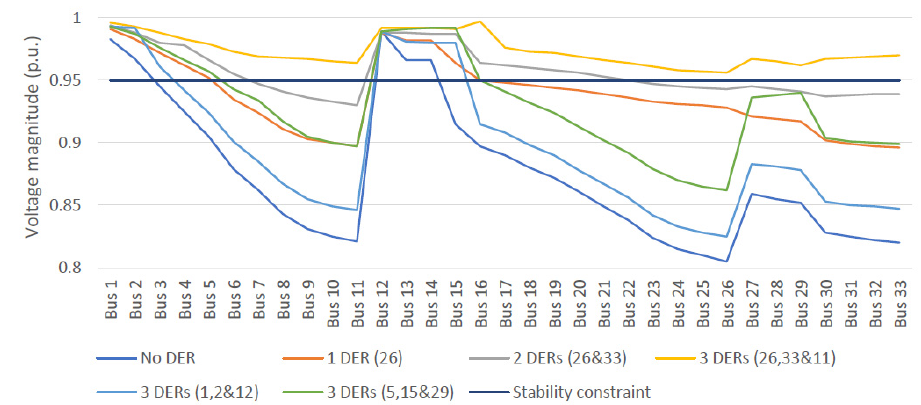
Figure 7. Voltage profile improvement with DER units placement.